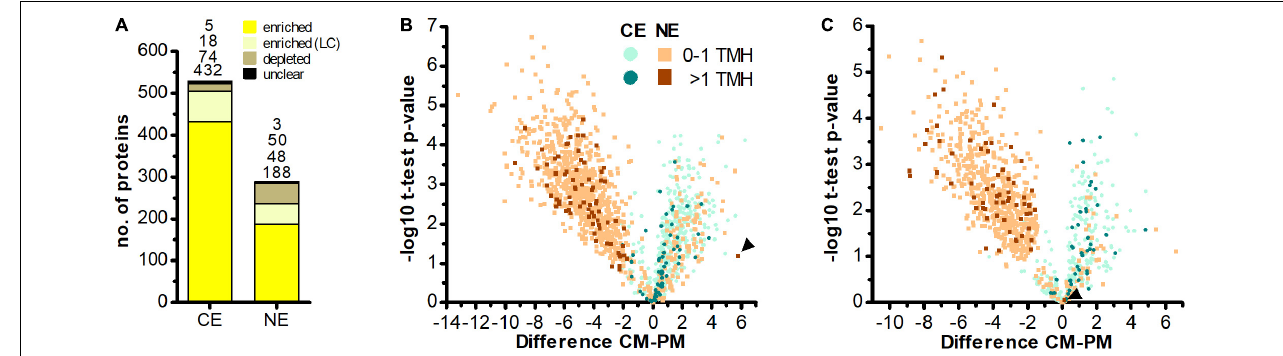
FIGURE 3 | No evidence for import of host-encoded multi-spanning TM proteins into chromatophores. (A) Chromatophore-encoded (CE) and nucleus-encoded (NE) proteins enriched in CM compared to PM samples. Yellow, proteins enriched with high confidence; light yellow, proteins enriched with low confidence (LC); brown, proteins depleted in CM; black, proteins classified as “unclear” (see section “Materials and Methods” and Supplementary Figure S1 ). Only proteins identified with ≥ 3 SpC in the chromatophore samples in at least one out of two independent MS experiments were considered. (B,C) The difference of intensities of individual proteins between CM and PM samples ( log 2 ( normInt CM ) − log 2 ( normInt PM ) ; Difference) is plotted against significance (-log10 p -values in Student’s t -test) for proteins detected with ≥ 3 SpC in the chromatophore samples (for proteins detected in CM only or CM and PM) or in whole cell samples (proteins detected in PM only). Values for proteins detected only in one sample have been imputed and are only shown when their difference is significant. The number of predicted TMHs (outside of the crTP) is indicated by a color code. Data from MS experiment 1 (B) and 2 (C) are shown separately. Scaffold1608-m.20717 and scaffold18898-m.107131 (see text) are marked by arrowheads in (B,C) , respectively. In both analyses, among the proteins enriched in CM (Difference CM-PM > 0), the proportion of identified multi-spanning TM proteins encoded in the chromatophore (49 of 409 in B ; 39 of 134 in C ) as compared to the nucleus (0 of 132 excluding the false positive in B ; 1 of 54 in C ) is significantly higher (both: p- value = 0.002, Fishers’s Exact